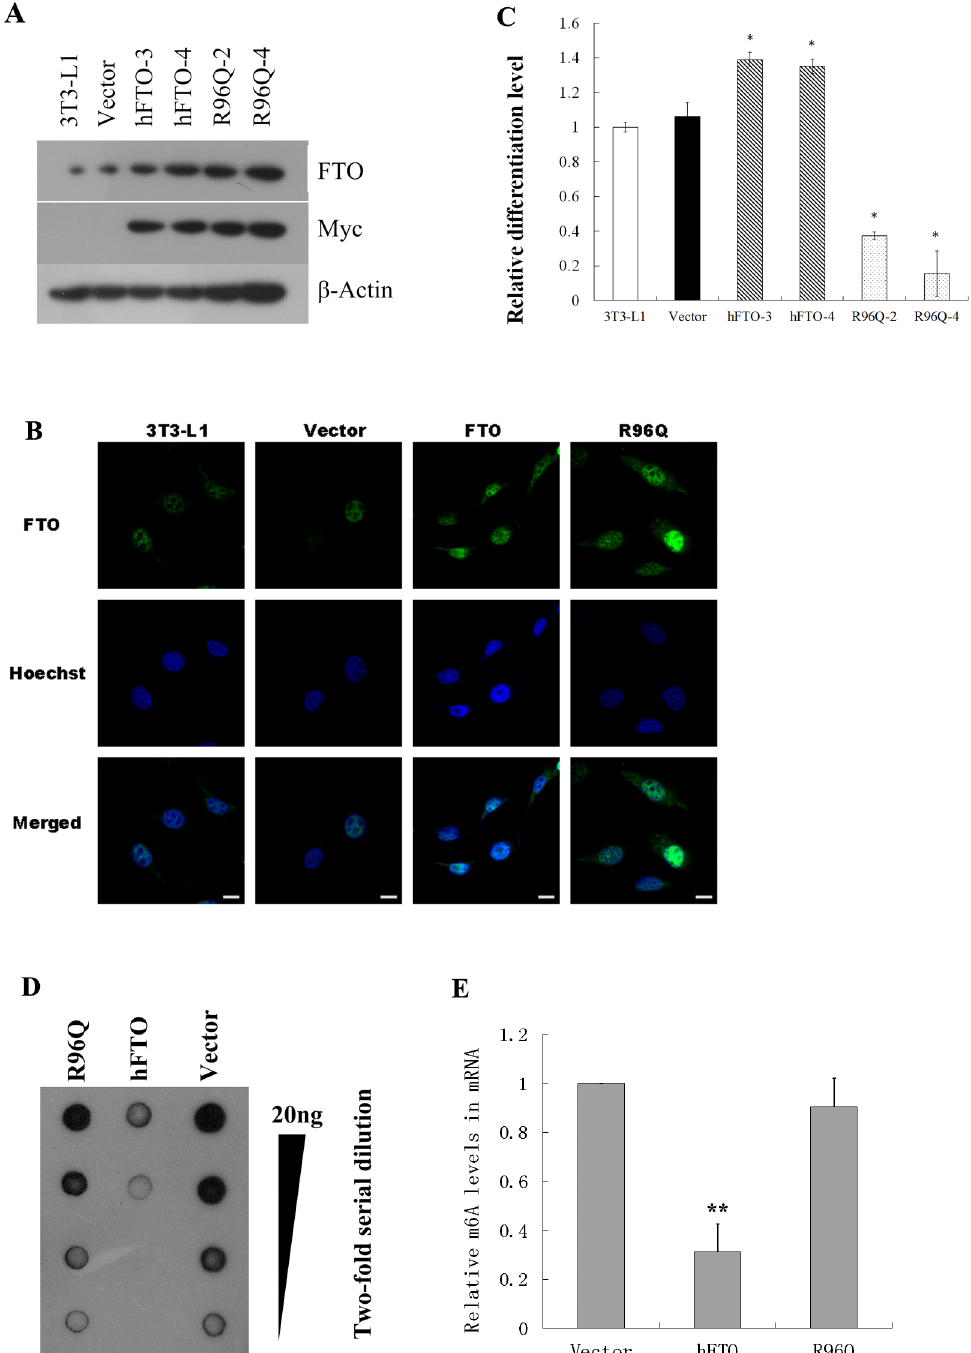
Fig 2. The demethylase activity of FTO is required during 3T3-L1 differentiation. Two lines of 3T3-L1 stably expressing wt FTO (hFTO-3 and hFTO-4) or R96Q (R96Q-2 and R96Q-4) were generated. (A) The protein expression level was confirmed by Western-blot using FTO and Myc antibodies, with β -actin as a loading control. (B) The sub-cellular localization of hFTO-4 or R96Q-4 was determined with confocal fluorescence imaging. Scale bars of 10 μ m are shown in the bottom row of images. (C) 3T3-L1differentiation was enhanced by over-expression of wt FTO and inhibited by R96Q. Level of differentiation was measured by extent of Oil Red-O staining at day 6 post differentiation induction (see materials and methods). Demethylase activities of wt hFTO-4 and R96Q-4 in 3T3-L1 cells were determined by dot blotting (D) and quantified by Grayscale analysis with ImageJ software (E). Data are represented as means ± SD of four replicates. * stands for p < 0.05 and ** stands for p < 0.01in Student ’ s t-test.